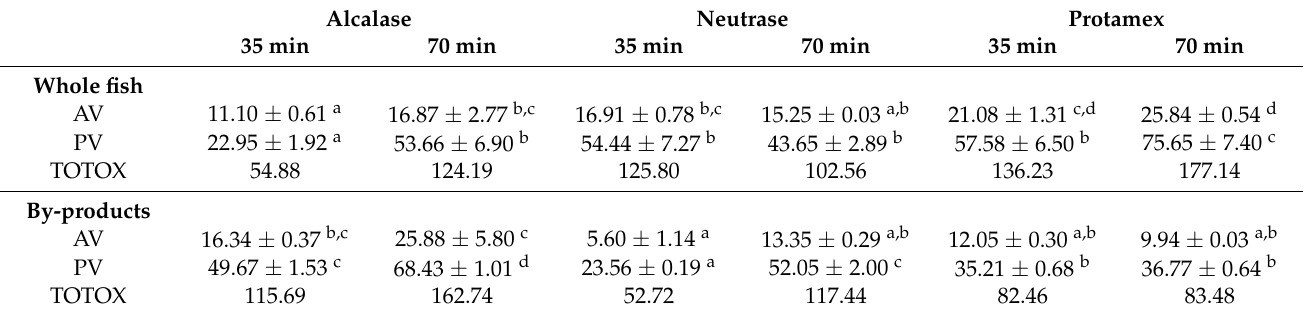
Table 4. p -Anisidine values (AV), peroxide values (PV) and total oxidation product (TOTOX) values of different enzymat- ically extracted oils. The results for AV and PV are shown as mean value ± standard deviation. Significant differences ( p < 0.05) were determined by one-way ANOVA and Tukey HSD. Alcalase Neutrase Protamex 35 min 70 min 35 min 70 min 70